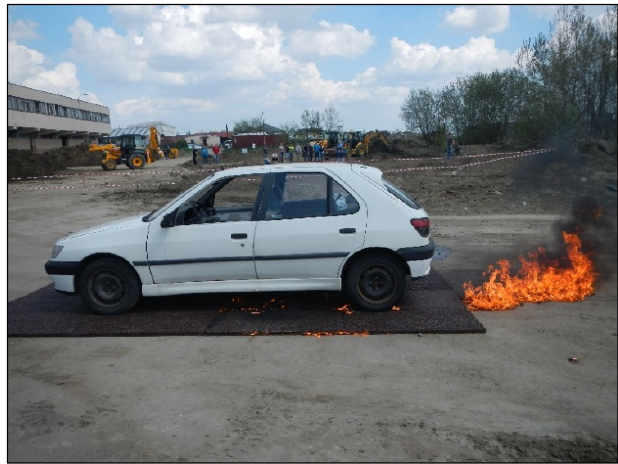
Figure 12. Car fire 30 s after ignition. Observe the fuel spill at right side of a car that is still not ignited [12].